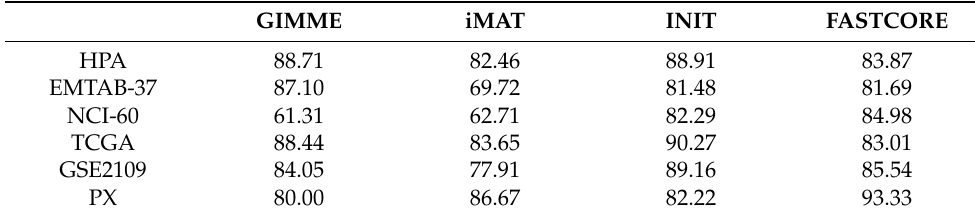
Table 6. The percentage of statistically significant disagreement among CGEM pairs in Bland–Altman analysis ( p -value <